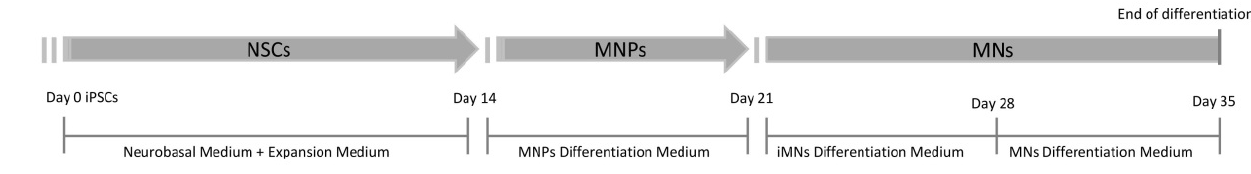
Figure 6. Workflow for MN differentiation. Induced pluripotent stem cells (iPSCs) were cultured for 14 days for the differentiation in NSCs and their expansion. At day 14, the medium was exchanged with MNP Differentiation Medium, which allowed the formation of MNPs in 7 days. MNs then formed in 14 days with the use of two different media, a medium for the formation of iMNs (iMN Differentiation Medium) and another one for their maturation (MN Differentiation Medium).